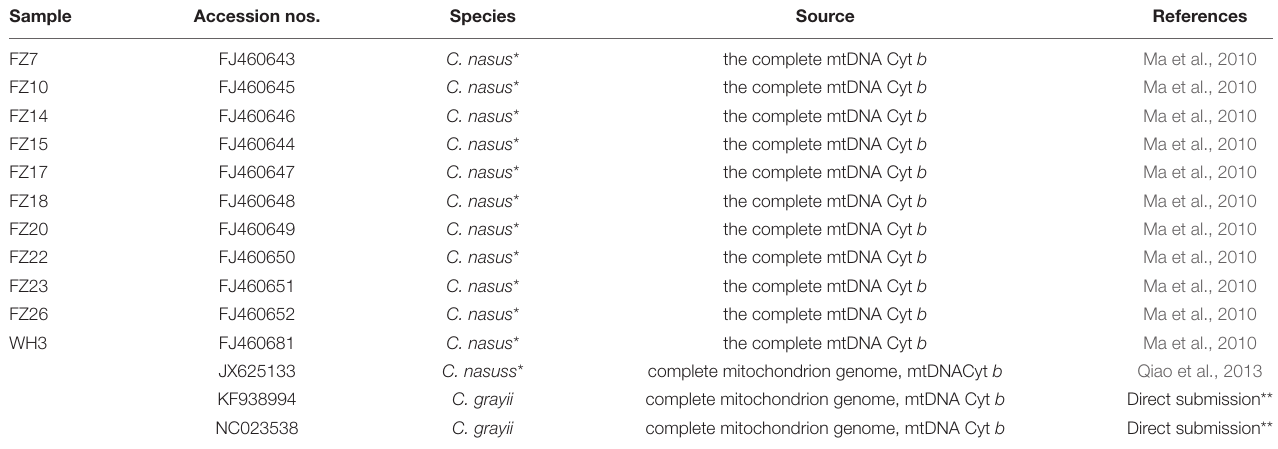
TABLE 2 | The origin of the homologous cytochrome b sequences of Coilia nasus and Coilia grayii. Sample Accession